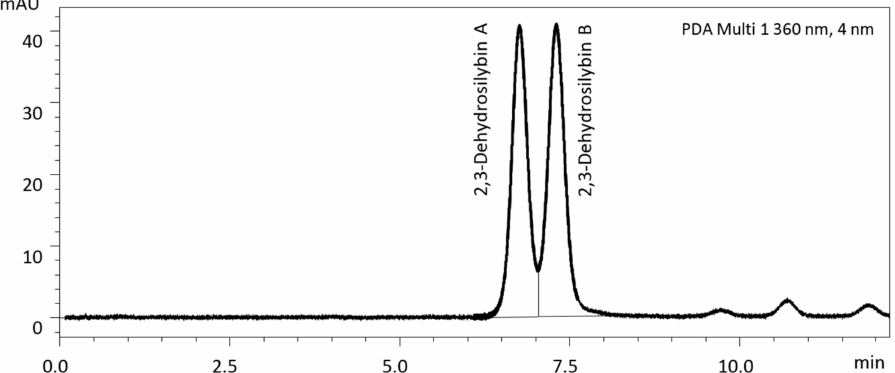
Figure 4. Separation of 2,3-dehydrosilybin enantiomers using chiral column Lux 3 µ Cellulose-4 (2 × 50 mm) and pre-column (4 × 2 mm) and binary gradient elution with mobile phase A: 10% acetonitrile, 0.1% formic acid, and B: 80% acetonitrile, 0.1% formic acid; gradient: 0 min 30% B, 0–12 min 30–50% B, 12–13 min 50–30% B, 13–15 min 30% B; flow rate 0.5 mL / min, t = 25 ◦